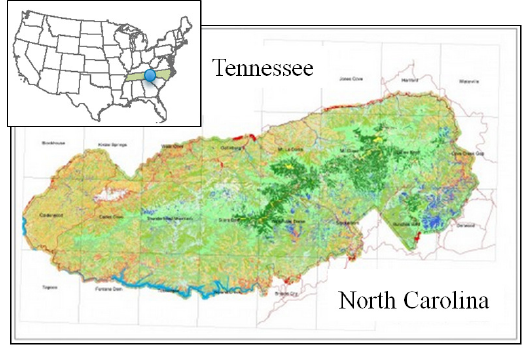
Figure 1: Vegetation cover map for the Great Smoky Mountains National Park. Inset map shows the location of the park (blue circle) between the states of Tennessee and North Carolina (shaded).